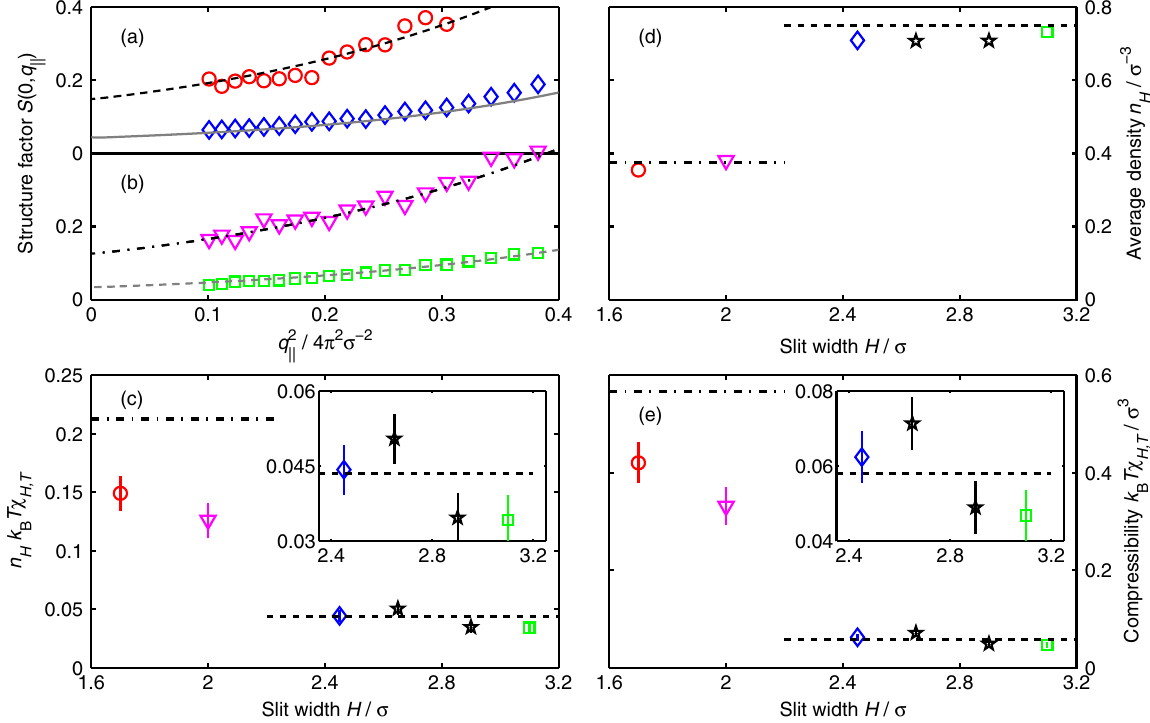
FIG. 8. (a,b) Long-wavelength limit of experimental and selected theoretical structure factors of Figs. 7(a) and 7(b), presented as functions of q 2 ∥ (see text for details and Fig. 7 for the color and curve symbol codings). (c) The isothermal compressibility in the form k T χ n , obtained from panels (a) and (b) by extrapolation of the experimental structure factor to q ∥ ¼ 0 . The error bars depict the H H;T B inaccuracy of the extrapolation. The inset shows a magnification of the data for the dense fluid. (d) Experimental average number densities n , as obtained from the density profiles of Fig. 2. The error bars are smaller than the symbol size. (e) Same as in panel (c), but H T χ showing the experimental isothermal compressibility as k . The dashed and dashed-dotted lines in panels (c) – (e) represent H;T B experimental bulk values for the dense and the moderately dense fluid, respectively. The data depicted by black stars in panels (c) – (e) have been determined from density profiles and structure factors for the dense fluid in slits of width H ¼ 2 . 65 σ and 2 . 90 σ , obtained from Ref.